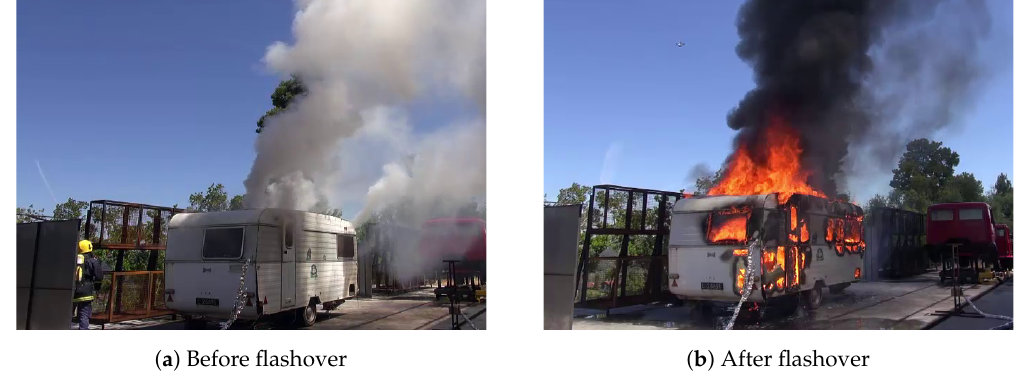
Figure 12. Recording of the caravan burning